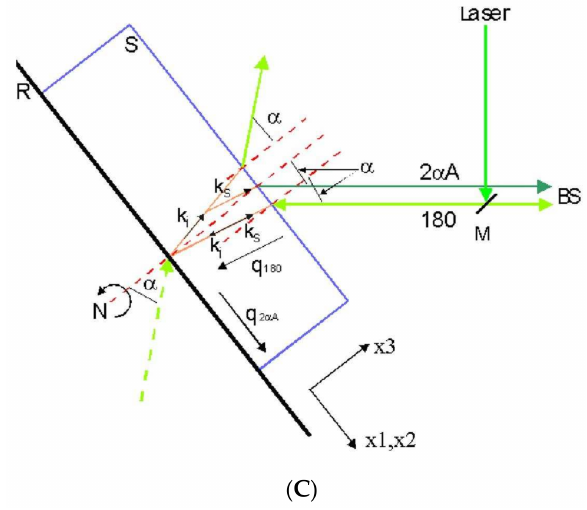
Figure 3. Representation of different scattering geometries. ( A ) 90 A and 180 as used in solid transparent samples or liquids inside a cuvette. k i and k s are incident and scattered optical wave vectors, respectively. q 90 A and q 180 correspond to acoustic wave vectors. ( B ) Scattering geometry in an opaque material. ( C ) Scattering geometries in a film on a reflecting substrate. The reflected light beam acts as a virtual one from behind the sample. Two scattering geometries exist simultaneously: 180 and 2 α A